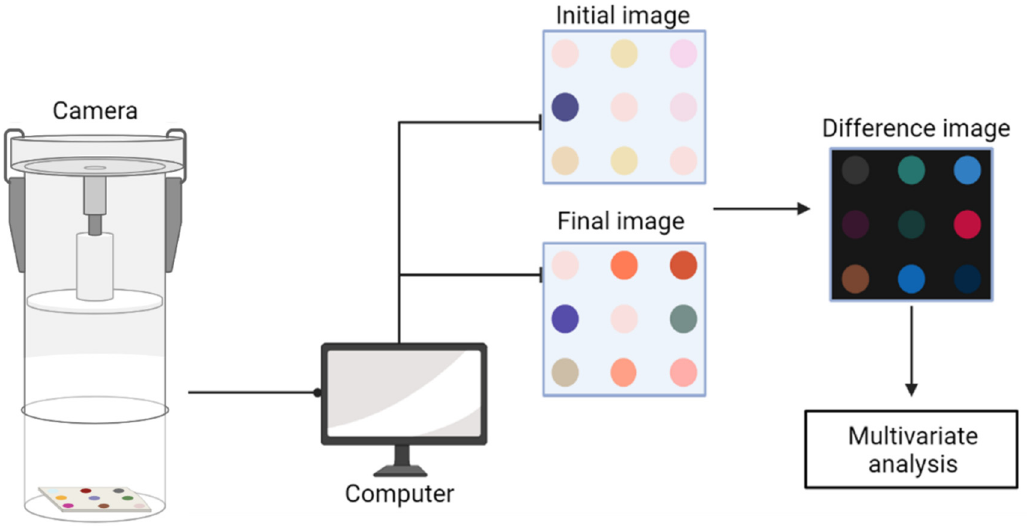
Figure 1. Schematic diagram of color sensor array